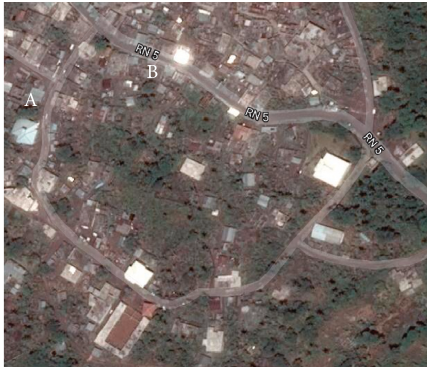
Figure 1: Aerial view of sampling sites (village of Ouziouani in Grande Comore). A: sample P1; B: sample